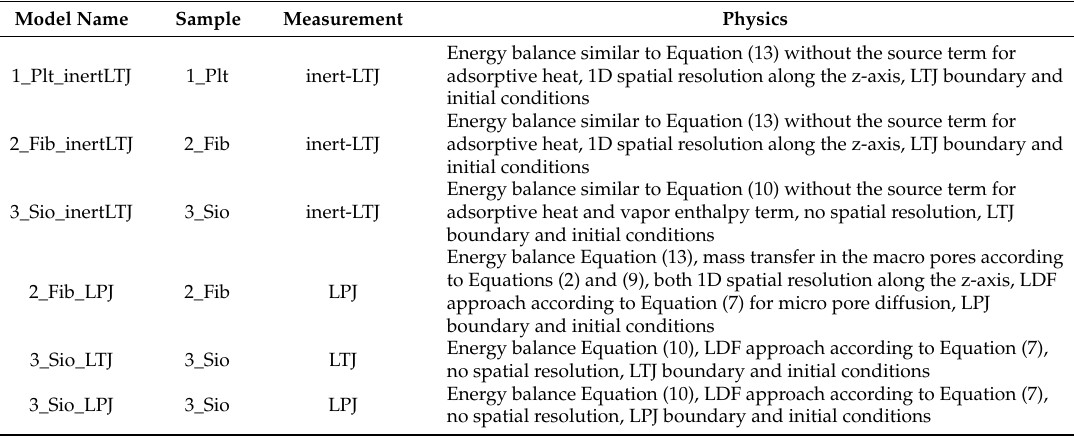
Table 4. Model overview. LDF, linear driving